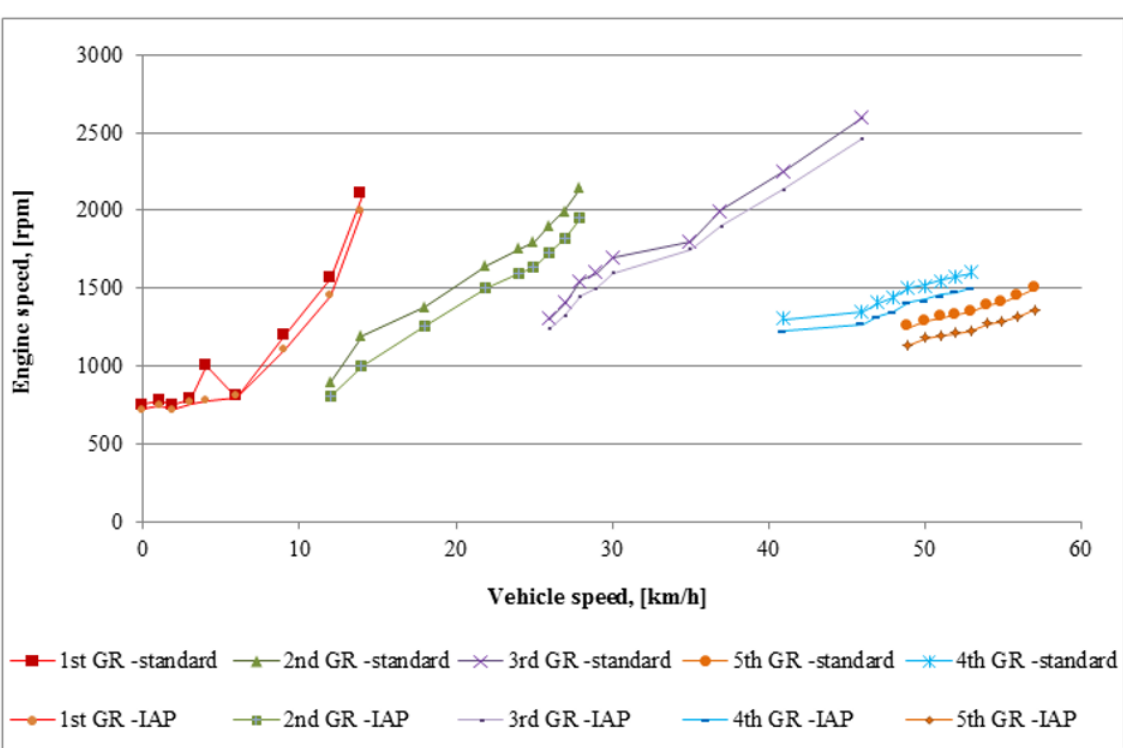
Figure 10. Engine speed versus vehicle speed for different gear